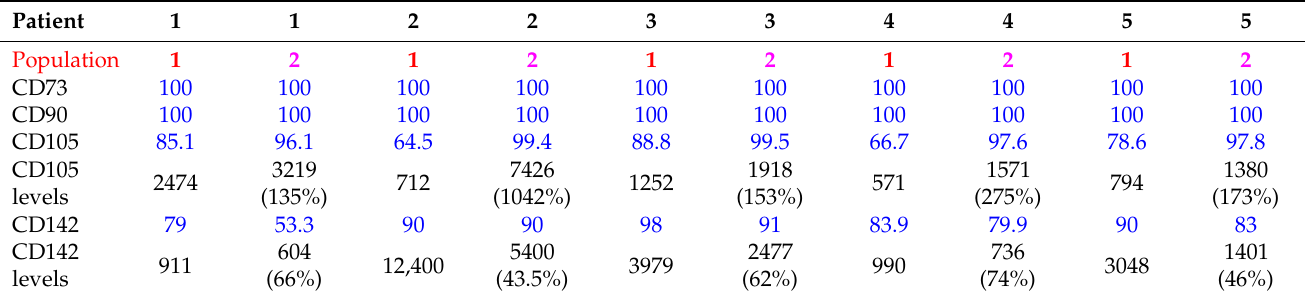
Table 1. FACS analysis of breast adipose progenitor cell (APC) markers